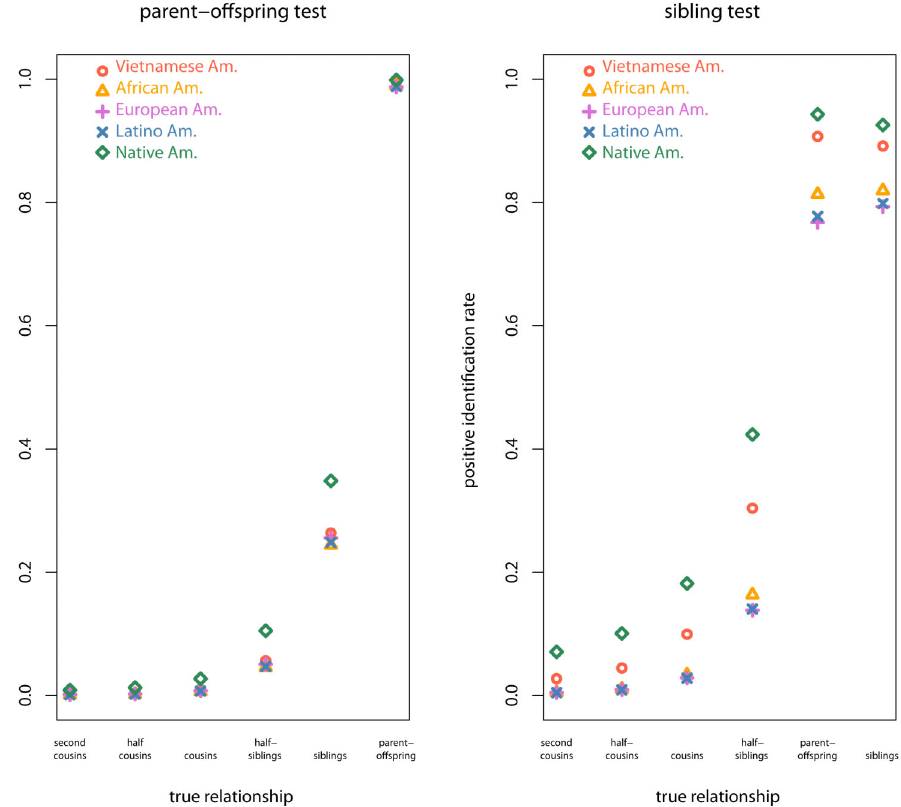
Figure 1. Distributions of the test statistic X , defined in (4), for sibling test for individuals who are siblings (solid red), parent- offsprings (solid black), half-sibs (dashed black), cousins (dashdot black), and second cousins (dotted black). The population sample individuals are sampled from is along the top and the assumed pop sample is along the side. doi:10.1371/journal.pone.0070495.g001 PLOS ONE |